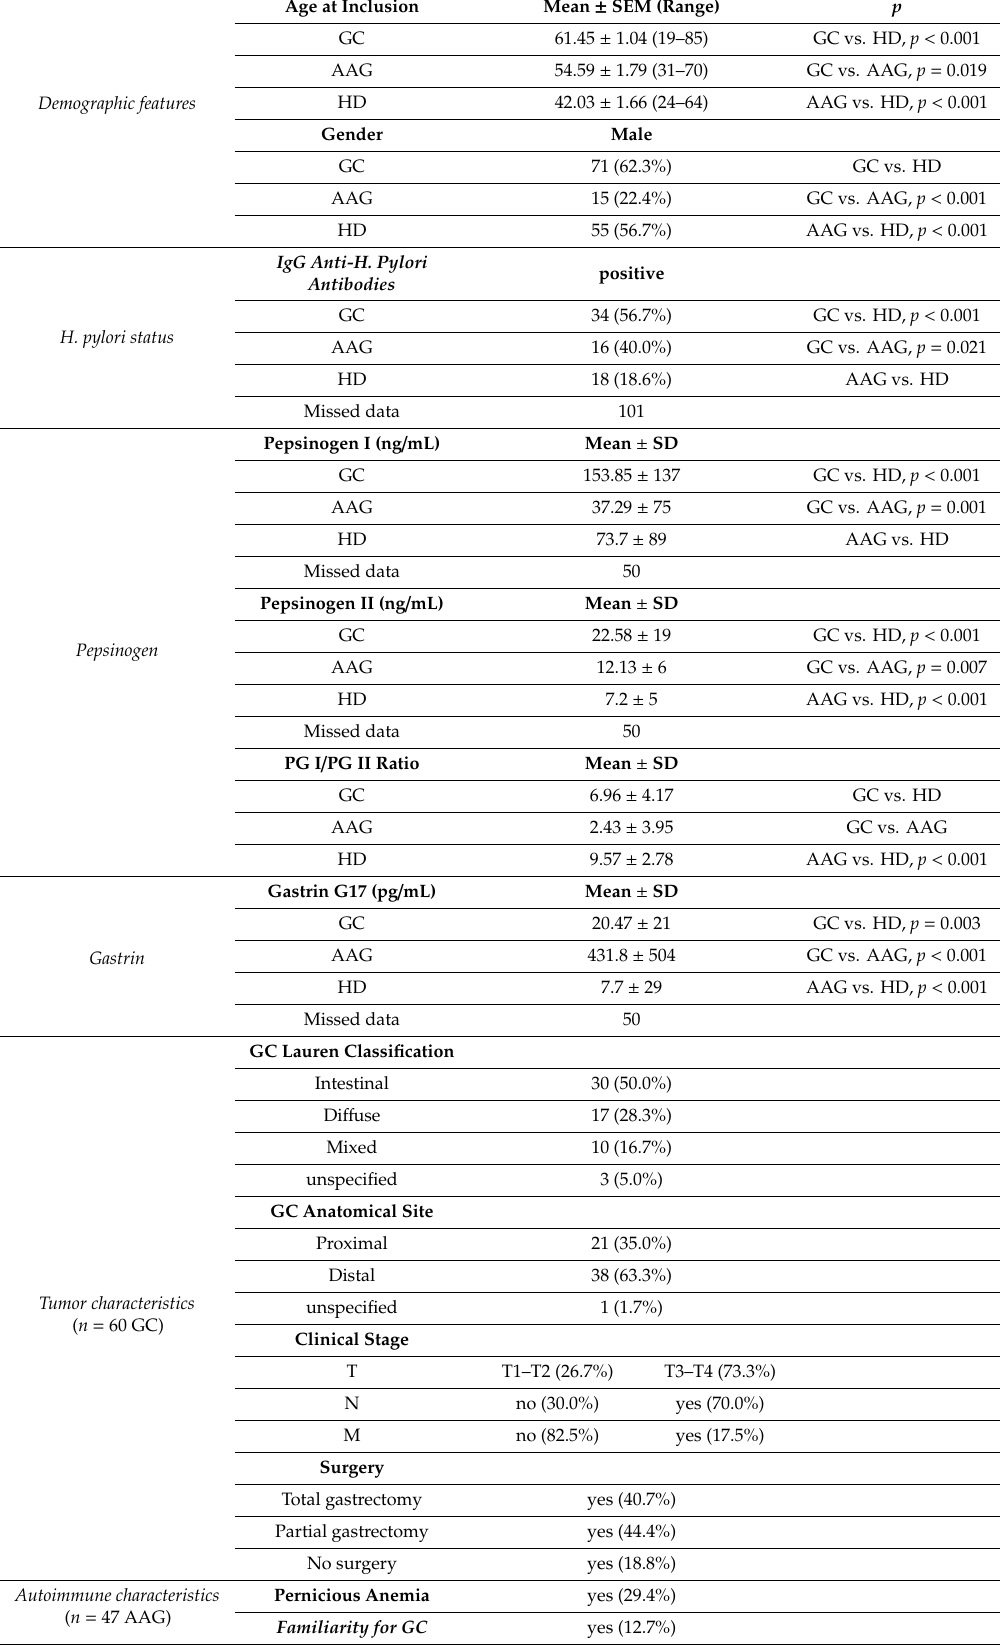
Table 1. Patient (GC n = 114, AAG n = 67) and healthy donors (HD n = 97)